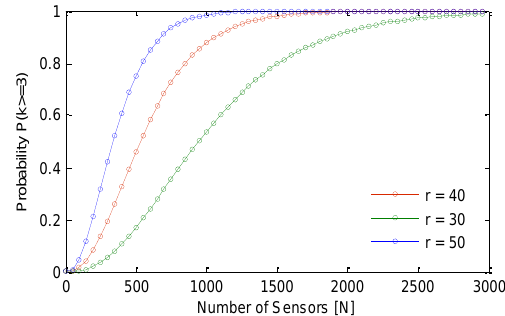
Figure 7. Probability distribution for P (k >= 3).